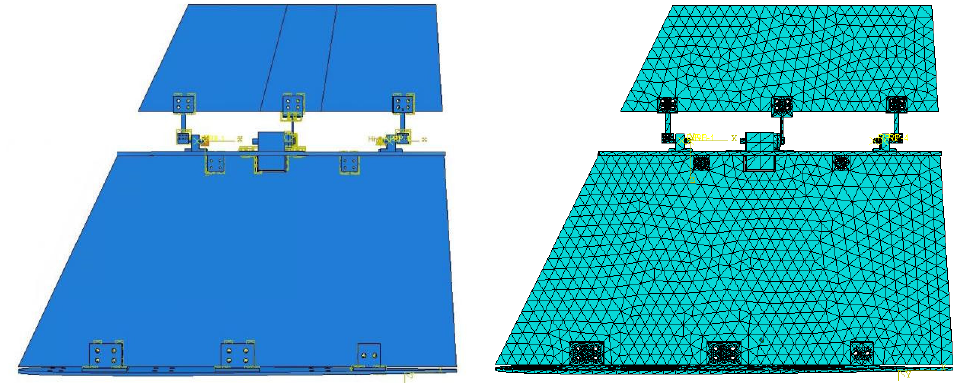
Figure 5. Similar model finite element model. Table 2. Material properties of major components. Table 2. Material properties of major